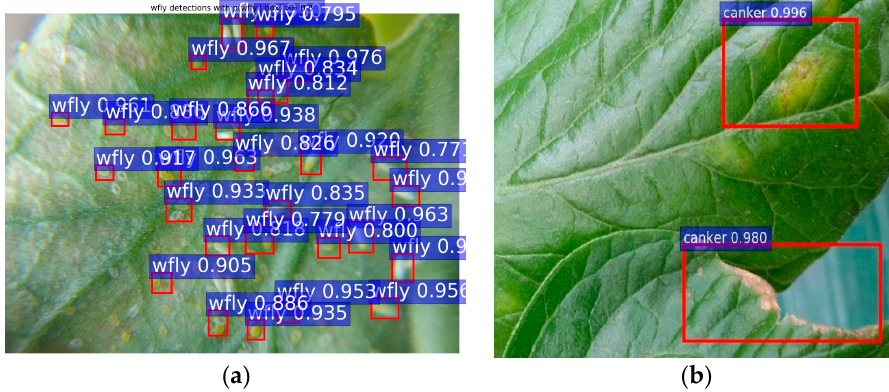
Figure 10. A representation of failure cases. ( a ) The intra-class variation makes the recognition harder and results in a low recognition rate. ( b ) Misdetected class due to confusion at earlier infection status (e.g., the real class is leaf mold, but the system recognizes it as canker).